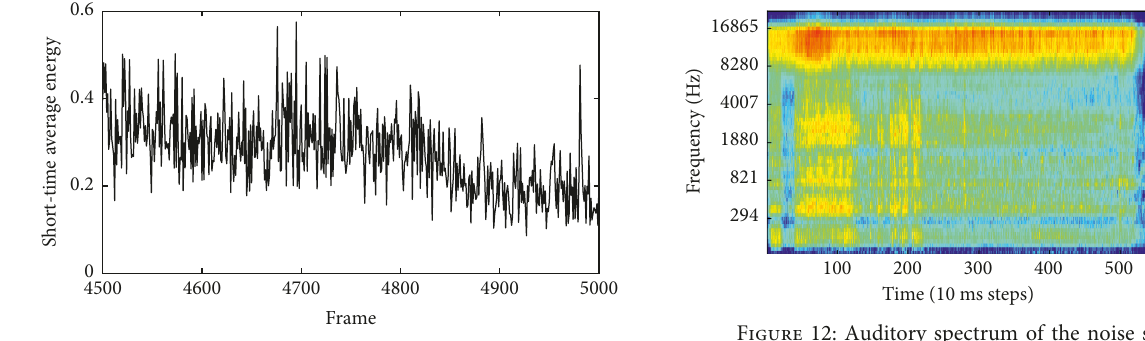
Figure 12: Auditory spectrum of the noise